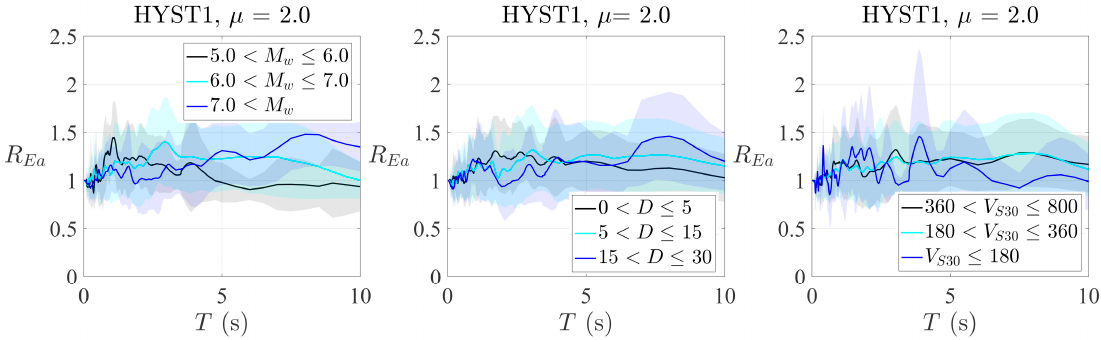
Figure 4. Spectra of the absolute input energy reduction factor R Ea for the hysteretic model HYST1 and ductility level μ equal to 2 considering different subsets of seismic records (filled area: envelope of the spectra; solid line: mean spectrum).